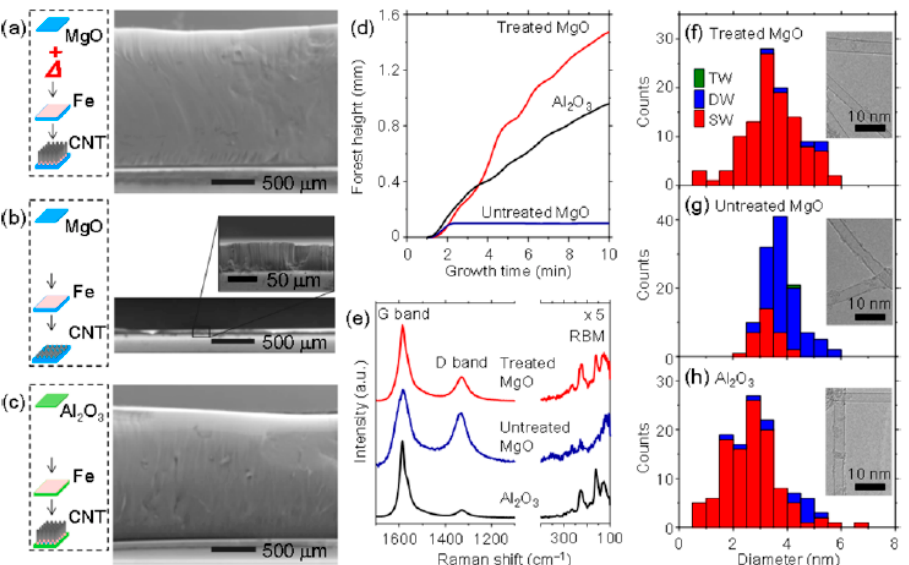
Figure 1. SEM micrographs of the VACNT grown on ( a ) annealed MgO, ( b ) MgO, and ( c ) Al 2 O 3 DBL (left side inserts: scheme of preparation) with details of ( d ) CNT growth kinetics and CNT